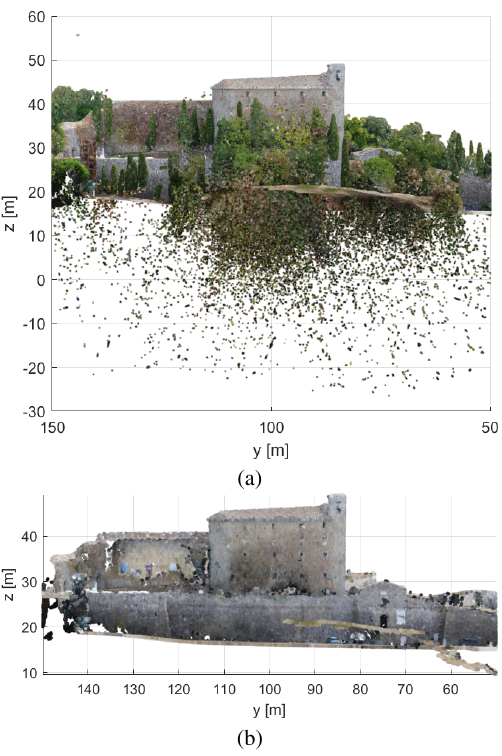
Figure 4. (a) West side view of the point cloud generated by Agisoft Photoscan. (b) Almost vegetation-free subsampled point cloud used for planar surface detection. Fig. 6 shows the resulting classification: “ground” points are shown (a), whereas the extracted fortress walls and ceiling are shown in (b) and